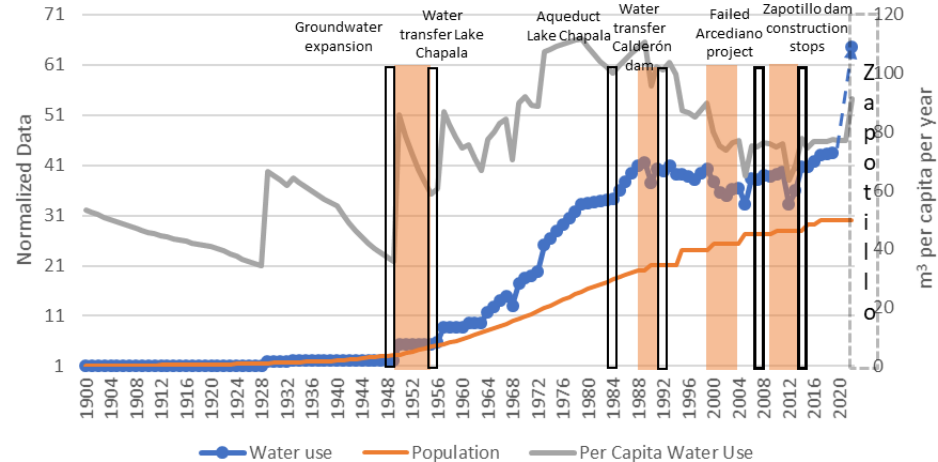
Figure 3. The reservoir effect in Guadalajara (the blue bars denote the implementation of a large supply augmentation schemes in 1947, 1956, and 1991, red bars the presence of droughts, and the dashed rectangle the official projected new water demand for the proposed large supply augmentation scheme). Sources of data: INEGI (1900, 1910, 1921, 1930, 1940, 1950, 1960, 1970, 1980, 1990, 1995, 2000, 2005, 2010, 2015), Duran Juárez and Torres Rodríguez (2001), Jalomo Aguirre (2011), Torres Rodríguez (2013), Conagua (2015), SIAPA (2014a, b, 2016, 2020), Gómez-Jauregui-Abdo (2015), and CEA Jalisco and Gobierno del Estado de Jalisco